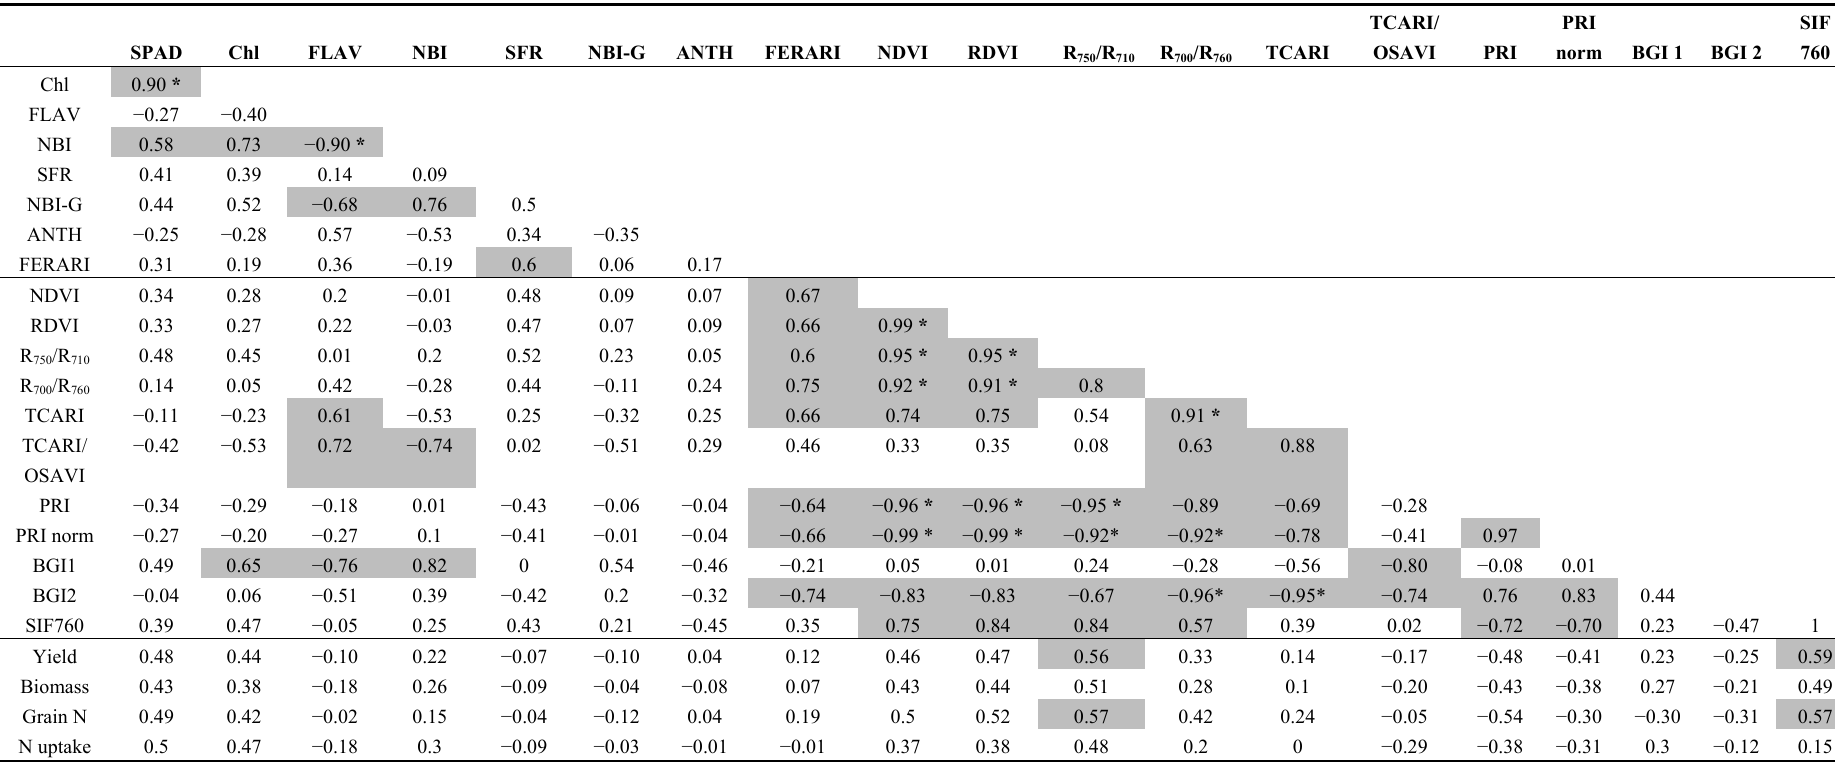
Table 4. Pearson correlation coefficients obtained for the linear correlations between optical indices and between optical indices and crop parameters at maize stem